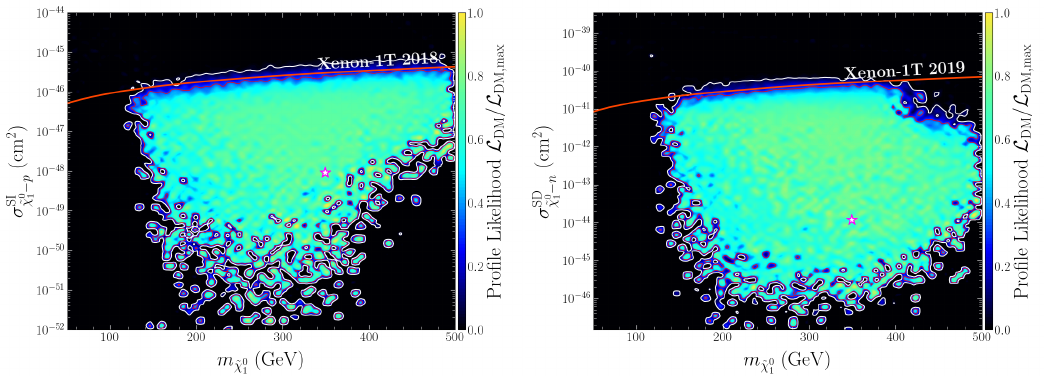
and σ SD − m − m ˜ χ 0 1 ˜ χ 0 1 ˜ χ 0 1 − p ˜ χ 0 1 − n